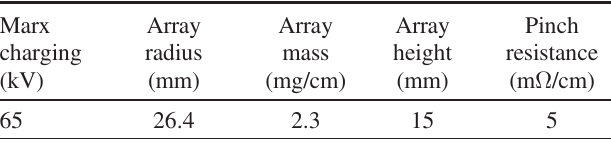
TABLE I. Marx charge voltage and load parameters for PTS shot 0057. The pinch resistance is assumed according to Refs. [11] and [33]. These parameters, together with the laser timing sequence, were used as input for the code